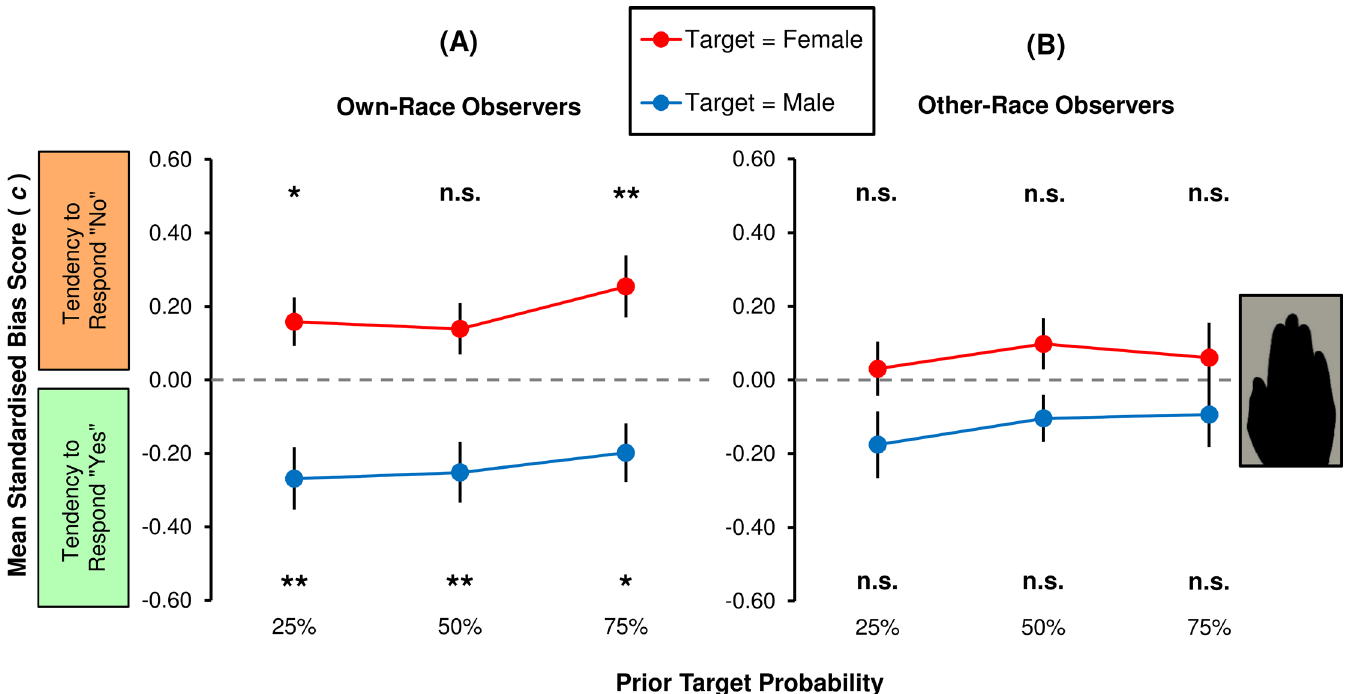
Fig 5. Group bias rates for extended (1000 ms) presentations of silhouette hands. Performances in the ambiguous ‘ silhouette ’ condition are plotted separately for ( A ) own-race observers and ( B ) other-race observers. Means denoted ** differ from c = 0.00 at the .01 level of significance. Means denoted * and ‘ n.s. ’ correspond to significance values .01 < p < .05 and p > .05, respectively, and therefore are not significant at the per-comparison criterion of α = .008. Vertical bars represent ± 1 SEM